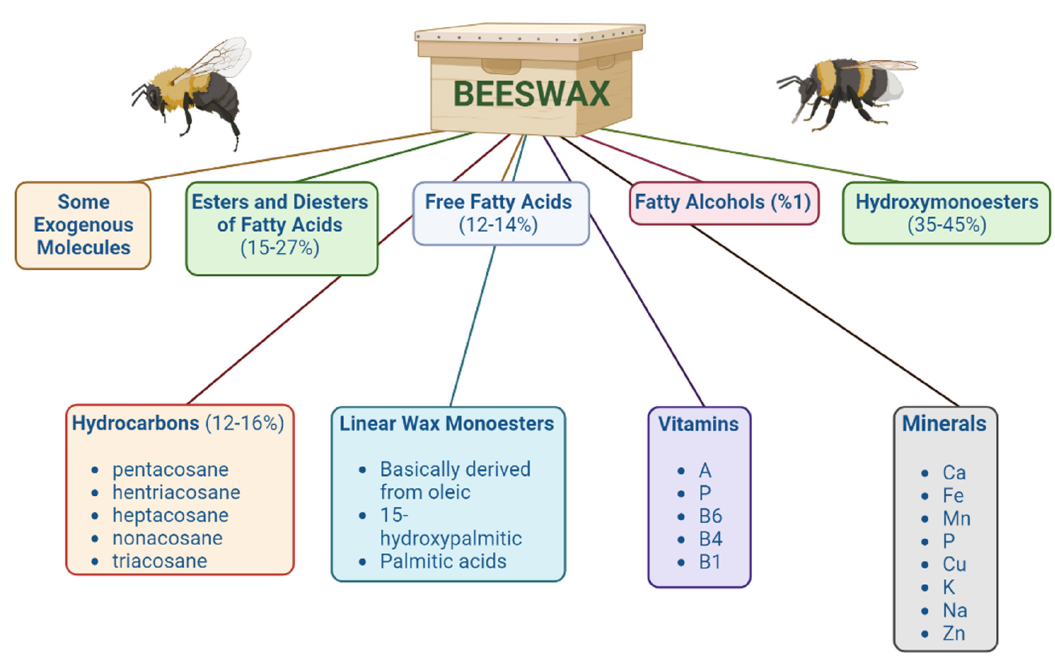
Figure 8. General composition of beeswax.